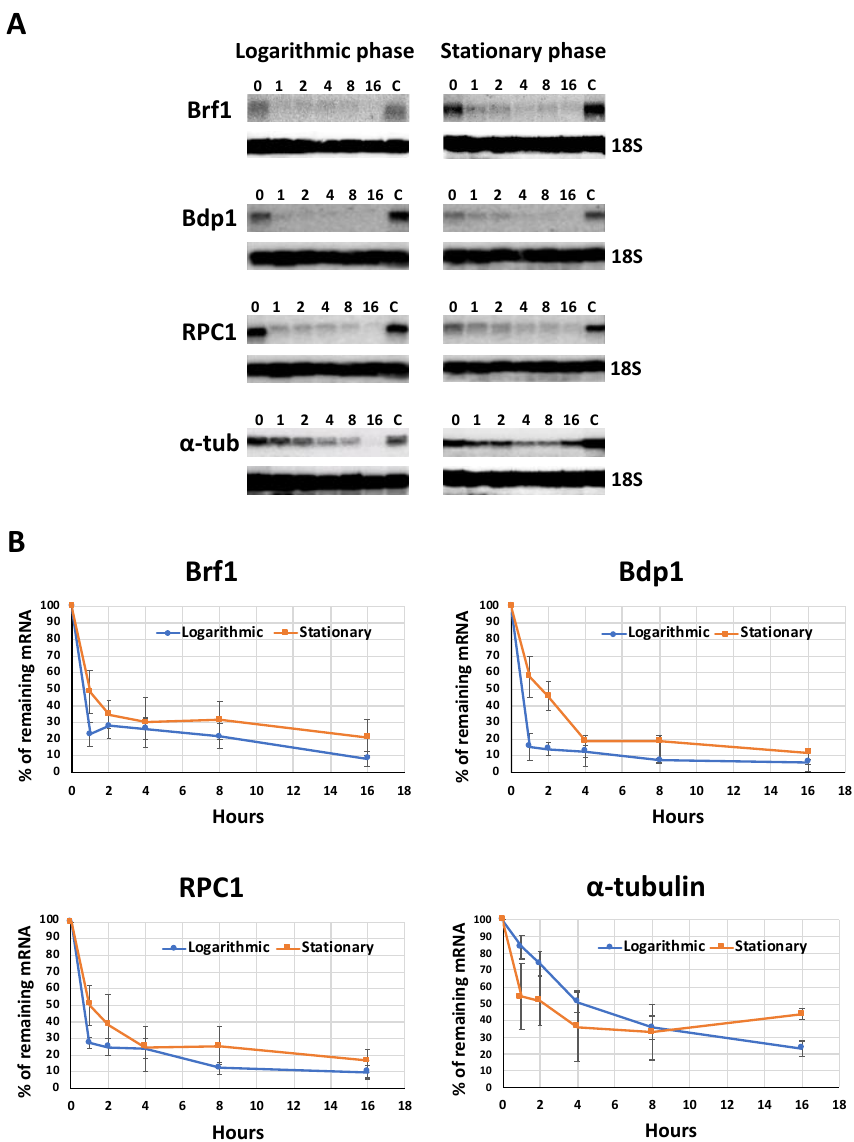
Figure 3. Half-lives of messenger RNAs (mRNAs) from Brf1, B double prime 1 (Bdp1), and RPC1. ( A ) Northern blots with total RNA from cells treated with actinomycin D (10 µ g/mL) to inhibit transcription. RNA was isolated from logarithmic phase or stationary phase parasites at several time points (0, 1, 2, 4, 8, and 16 h) after addition of the drug. As a control, RNA from cells grown in the presence of dimethyl sulfoxide (10 µ L/mL of culture), the solvent of actinomycin D, was included (lanes C). Hybridizations were performed with radioactive probes that corresponded to Brf1, Bdp1, RPC1, and α -tubulin. As loading control, membranes were re-hybridized with an 18S ribosomal RNA (rRNA) probe. ( B ) mRNA decay curves. Signals from the experiment shown in panel A and from two independent experiments were quantified and plotted. Results are presented from logarithmic-phase (blue line) and stationary-phase (red line) parasites. Error bars represent standard deviations.